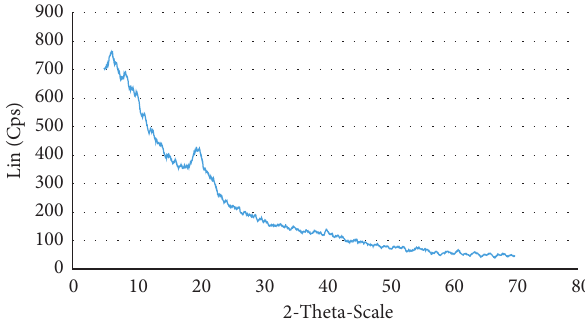
Figure 12: XRD diagram of the original chitosan.